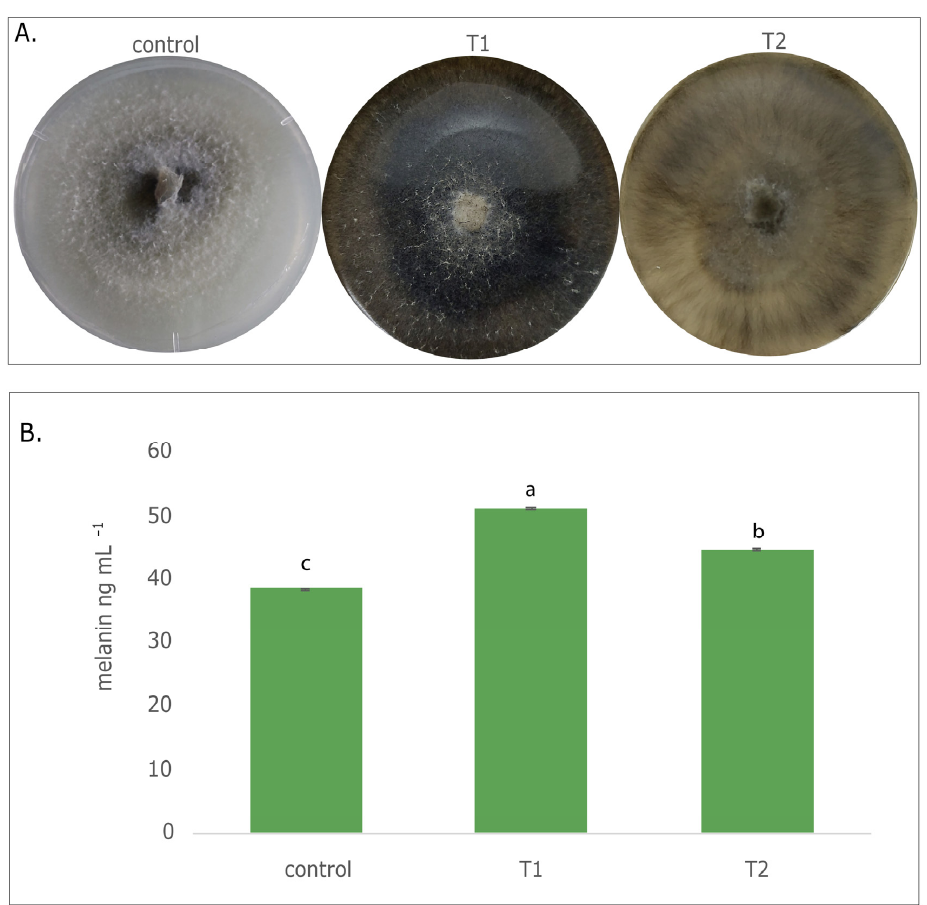
Figure 1. ( A ) Melanin fungal pigment production, (c) control, T1: Ultraviolet light (UV-A 320–400 nm) as inductor factor, T2: Temperature (30, 15 and 20 °C) as inductor factor. ( B ) Melanin concentrations (ng mL − 1 ). Different letters denote significant difference ( p ≤ 0.05).